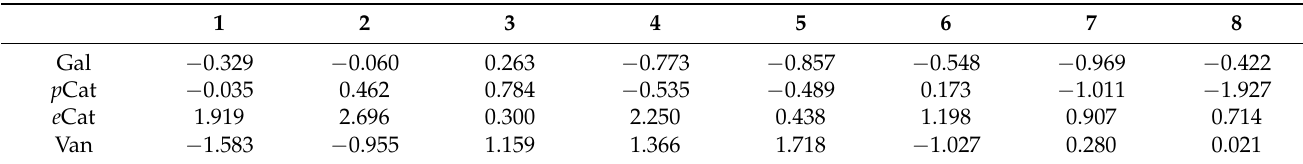
Table A1. Elements of matrix W 1 and vector B 1